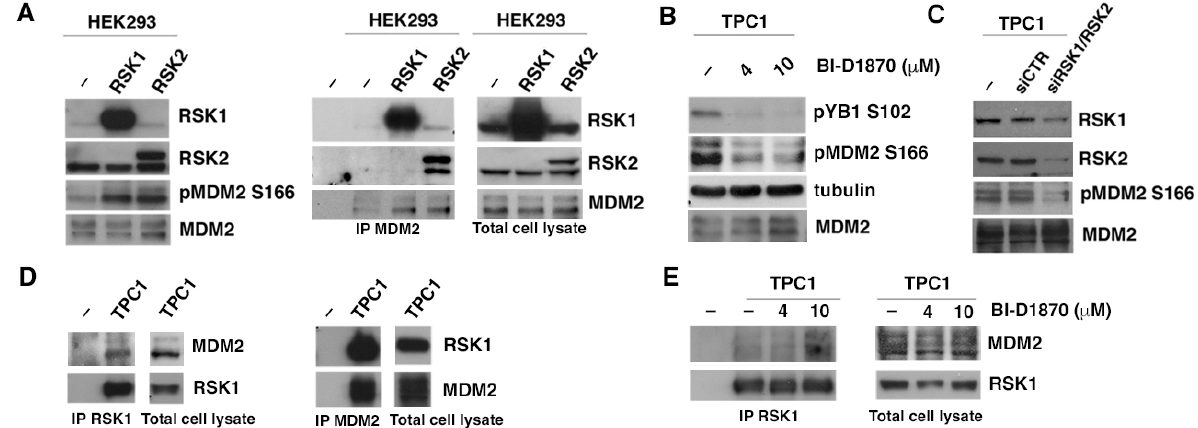
Figure 3. p90RSK binds and phosphorylates MDM2 on S166 in vivo. ( A ) Left panel—HEK293 cells were transfected with RSK1 and RSK2 expression plasmids. The transfection efficiency was verified by immunoblot with anti-RSK1 and anti-RSK2. The MDM2 phosphorylation level was assessed with the anti-phospho-S166 of MDM2. The experiment was normalized for total MDM2 ( A ) right panel—HEK293 cells were transfected with the plasmids encoding constitutively activated p90RSK1 and p90RSK2. The transfection efficiency was verified with anti-RSK1 and anti-RSK2 immunoblot. The experiment was normalized for total MDM2 (right panel). Proteins were immunoprecipitated with anti-MDM2 antibody and immunoblotted with anti-RSK1 and anti-RSK2 antibodies to verify the interaction and with anti-MDM2 antibody to normalize the immunoprecipitation (left panel); ( B ) TPC1 cells were treated with the indicated doses of BI-D1870 inhibitor. BI-D1870 inhibition efficiency was tested with the anti-phospho-S102 YB1 antibody. Phosphorylated MDM2 was revealed with anti-phospho-S166 MDM2 antibody. MDM2 total level was revealed with anti-MDM2 antibody. transfected with RNA interference against RSK1 and RSK2 (pool of specific RSK1/RSK2